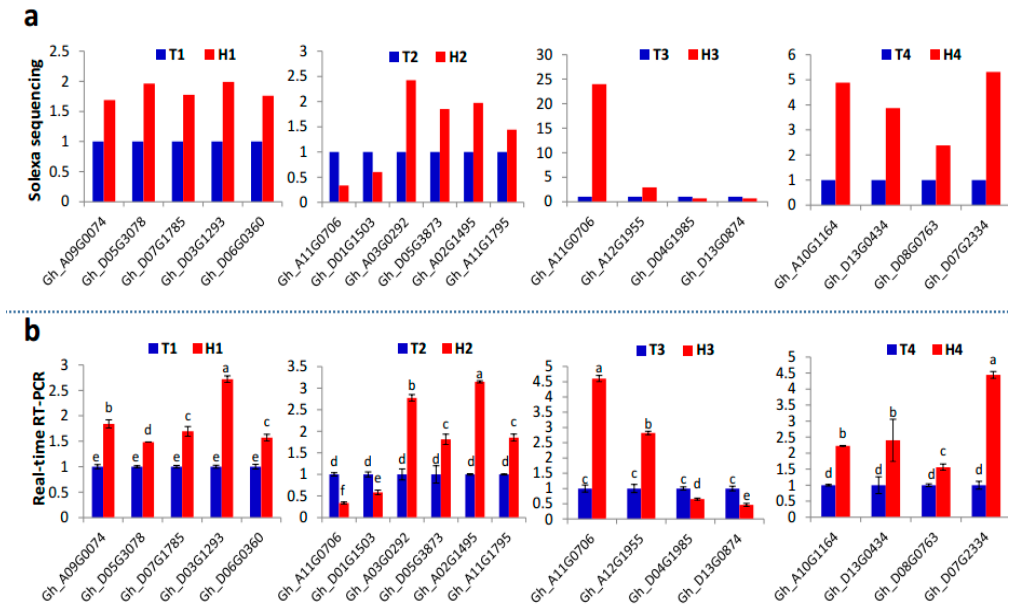
Figure 7. qRT-PCR validation of 19 predicted target genes identified by transcriptome sequencing. ( a ) Fold-change of the predicted genes at the four developmental stages under HT stress based on transcriptome sequencing data. ( b ) The relative expression of the same genes under HT stress detected by qRT-PCR and represented as means of three replicates ( n = 3) ± standard error. Significant differences indicated with letters above each bar ( p ≤ 0.05).